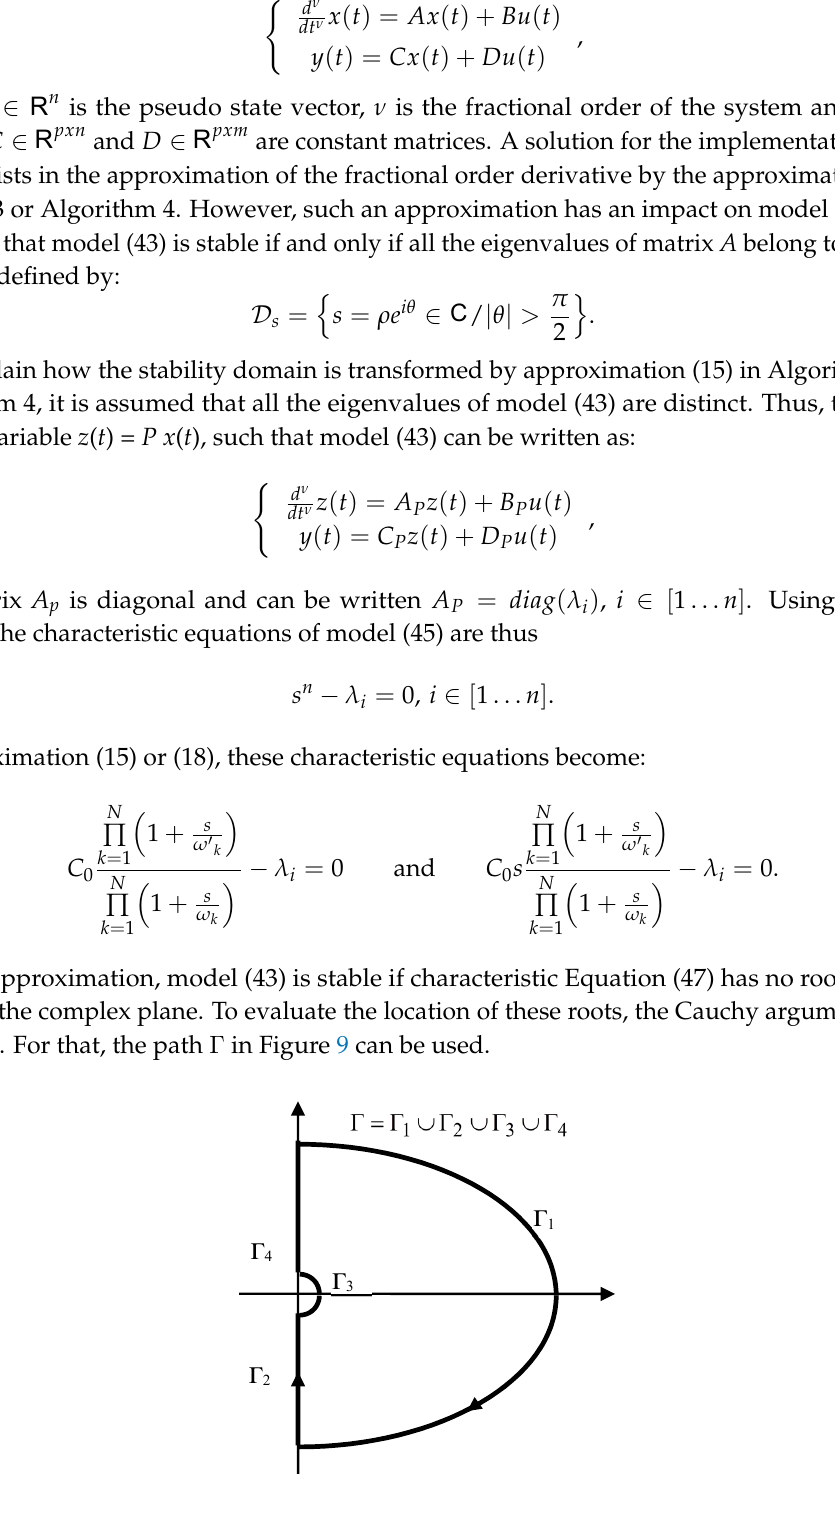
Figure 8. Comparison of relative ( left ) and absolute ( right ) errors between Algorithms 1 and 5 with distribution D 3 .